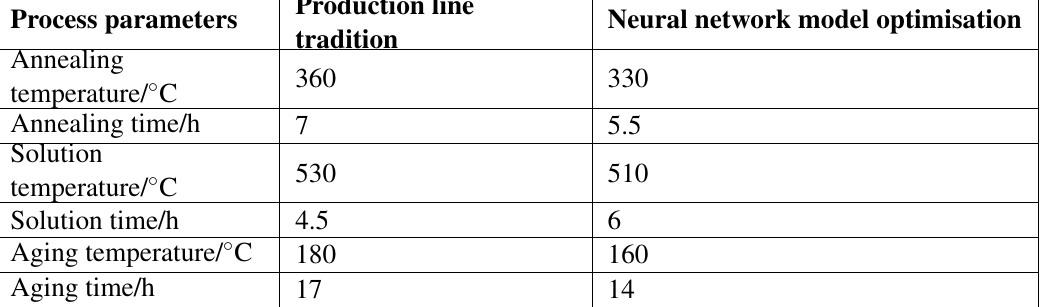
Fig. 3 Predictive verification results of the model. Table 2 Process parameters of 2618 aluminium alloy for automobiles